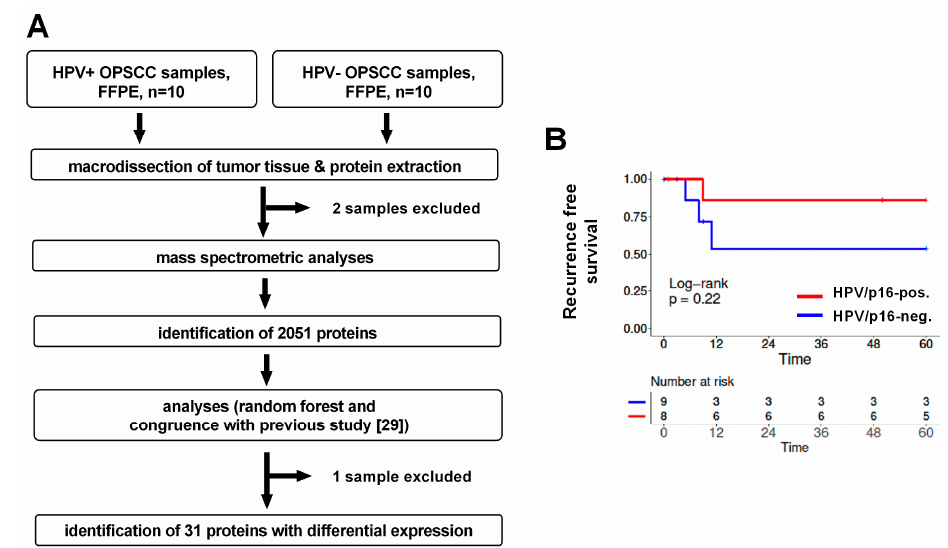
Figure 1. Experimental workflow and patient survival. ( A ) 10 HPV-positive and 10 HPV-negative OPSCC were initially chosen for the analysis. Two extracts were excluded from the mass spectrometric analysis because of insufficient amounts of protein. A single HPV-negative sample was further excluded from the random forest analysis because its expression pattern severely impaired group separation. For reasons of comparability, the sample was also excluded from protein identification based on congruence with a comparable previous study (through p -value and fold